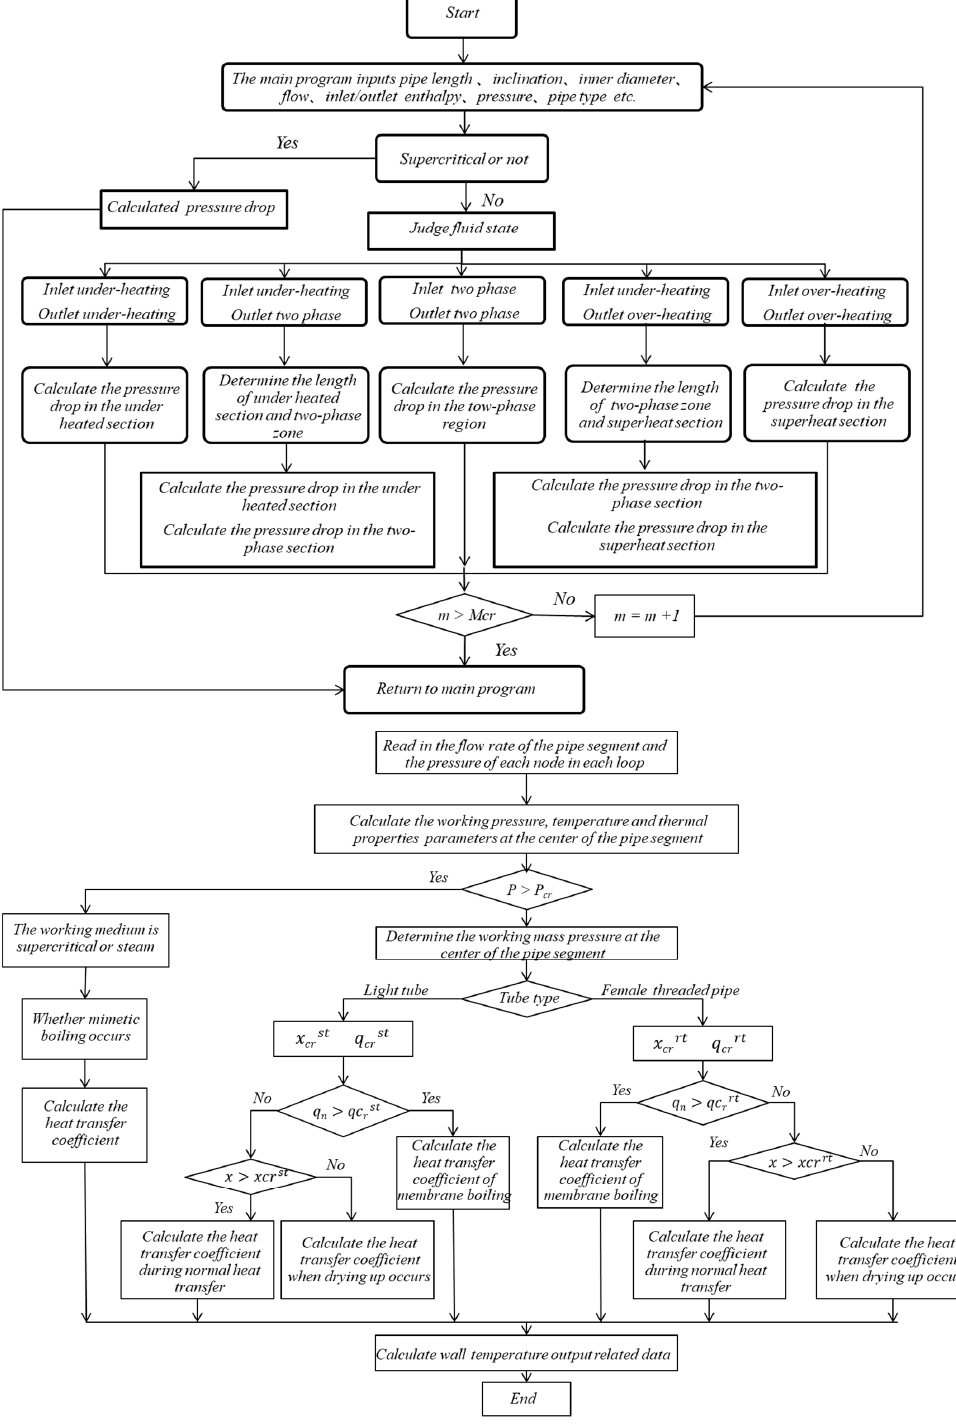
Figure 1. Calculation flow chart.